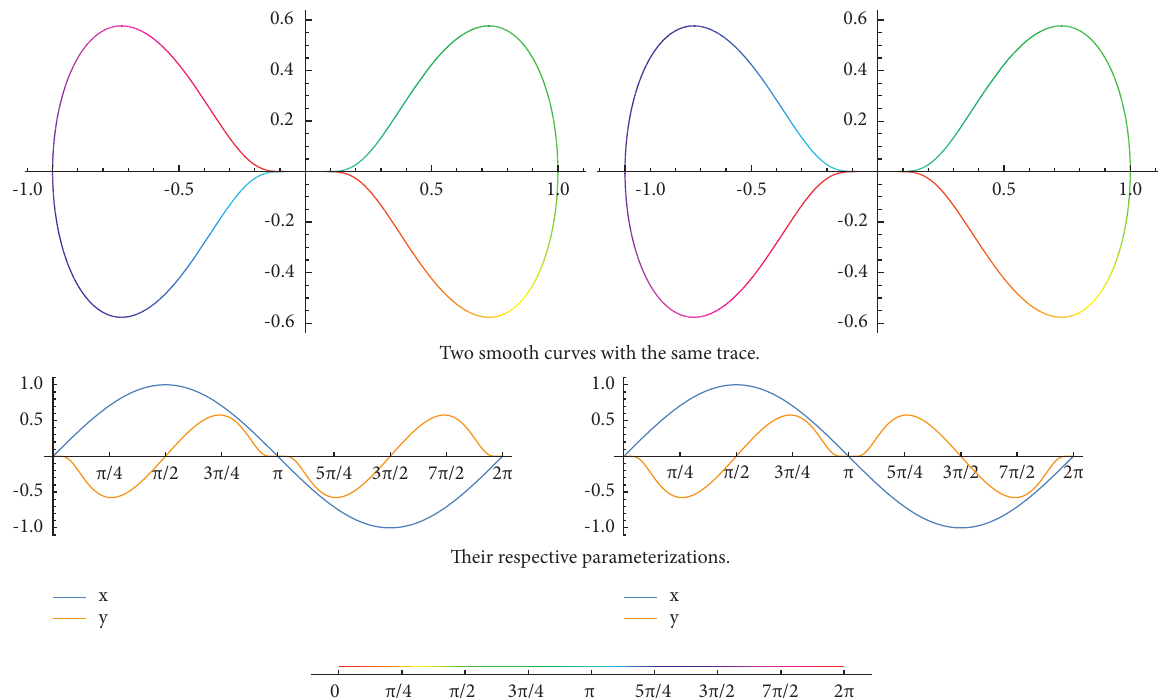
Figure 4: Trace of the two curves and parameterization defined in Example 4; with color scheme used for the